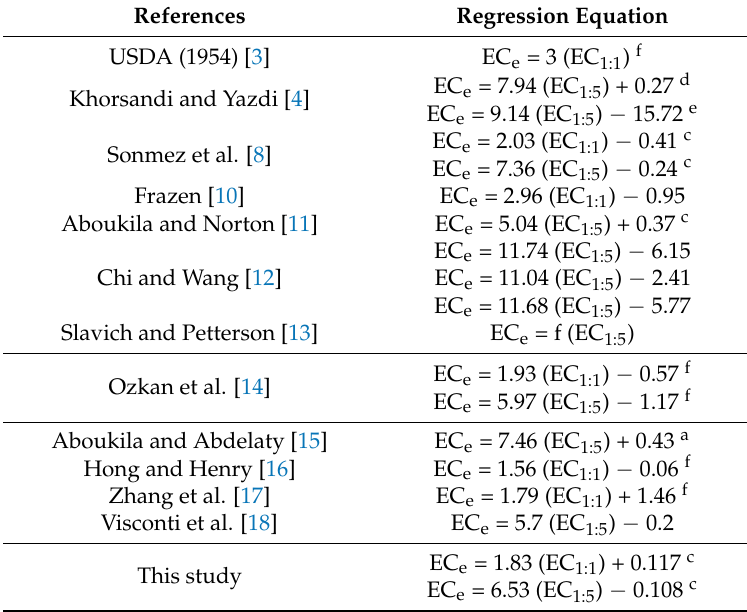
Table 1. The EC e = f (EC 1:5 ) and EC e = f (EC 1:1 ) relationships as proposed by several